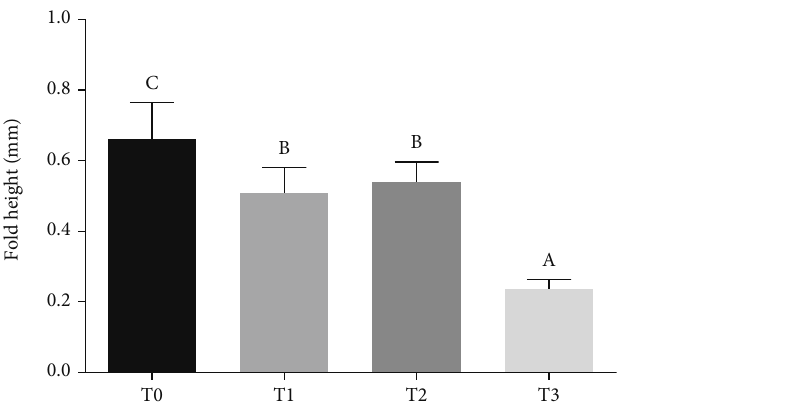
Figure 1: Fold height of hindgut in grass carp fed semipuri fi ed diets (mm) ( means ± SD , n = 10 ). Note: di ff erent lower-case letters indicate signi fi cant di ff erences ( P < 0 : 05